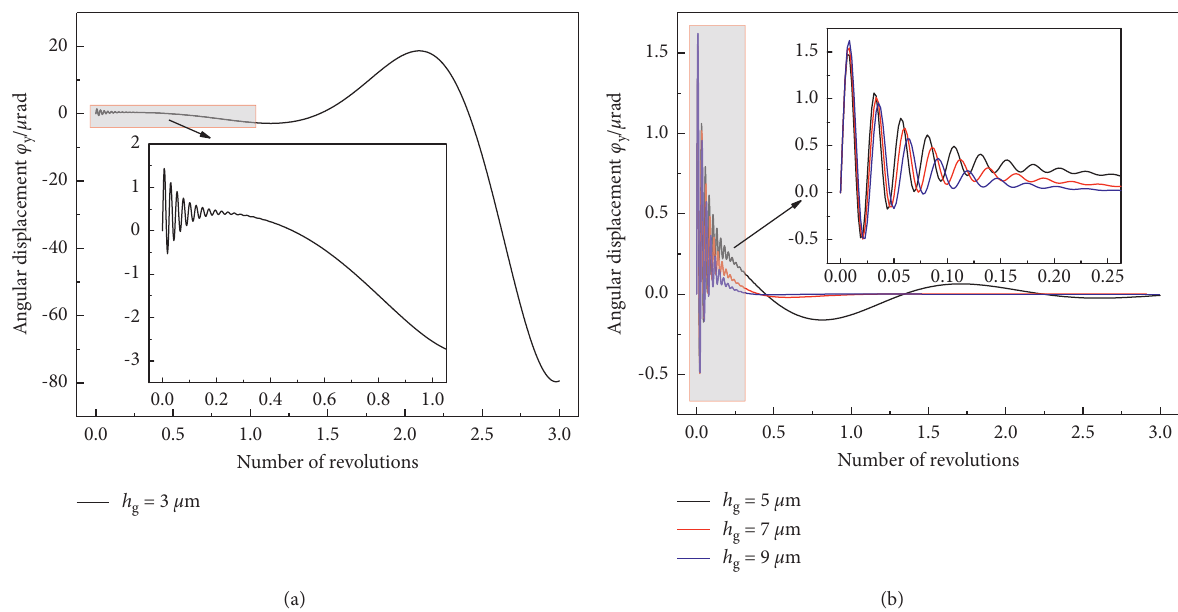
Figure 9: Angular response displacement of the floating ring solved by DNSM under different groove depth: (a) h